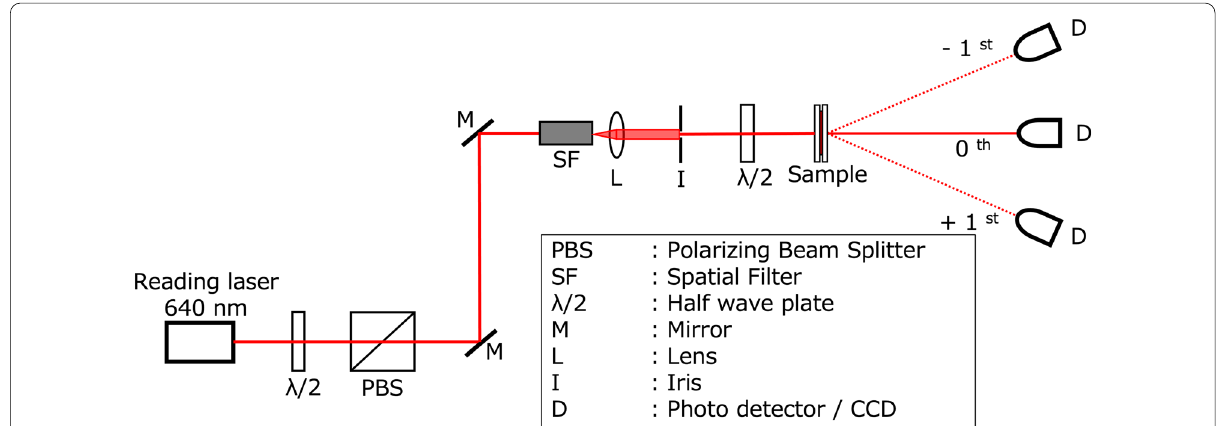
Fig. 8 Schematic of the optical set-up used for reconstructing the printed holograms and for capturing the reconstructed light intensity pattern